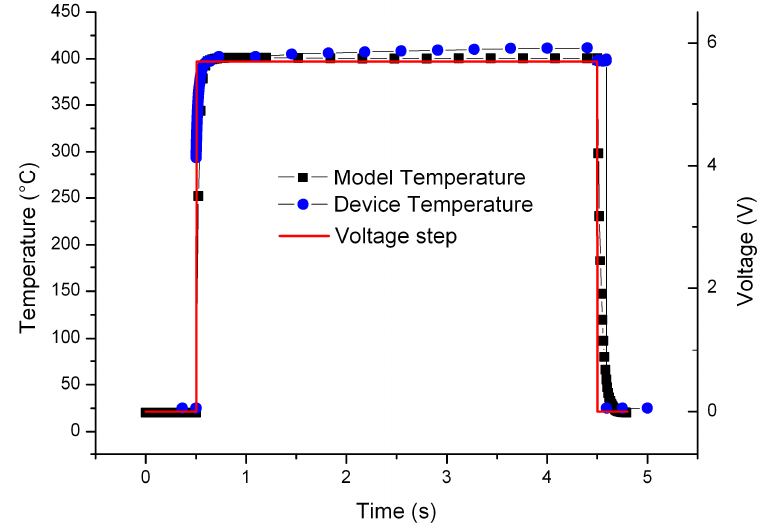
Figure 12. Response time to a step voltage input for the buried design: comparison between the model and the actual device.